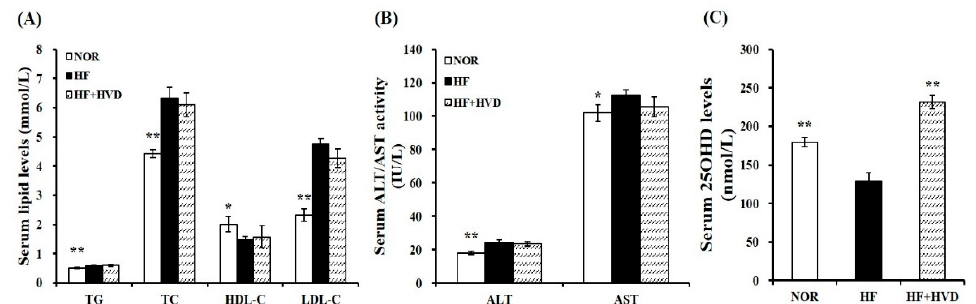
Figure 2. Effect of vitamin D supplementation on serum metabolic parameters. ( A ) Serum levels of TG, TC, HDL-C, and LDL-C. LDL-C = TC − HDL-C − (TG/5). ( B ) Serum ALT and AST activities. ( C ) Serum 25OHD amounts. Values are expressed as the mean ± SEM ( n = 9/group). NOR, 10% fat diet with 1000 IU vitamin D; HF, 60% fat diet with 1000 IU vitamin D; HF + HVD, 60% fat diet with 10,000 IU vitamin D. ALT, alanine transaminase; AST, aspartate aminotransferase; HDL-C, high- density lipoprotein-cholesterol; LDL-C, low-density lipoprotein-cholesterol; TC, total cholesterol; TG, triglyceride. * p < 0.05; ** p < 0.01 compared to the HF group.